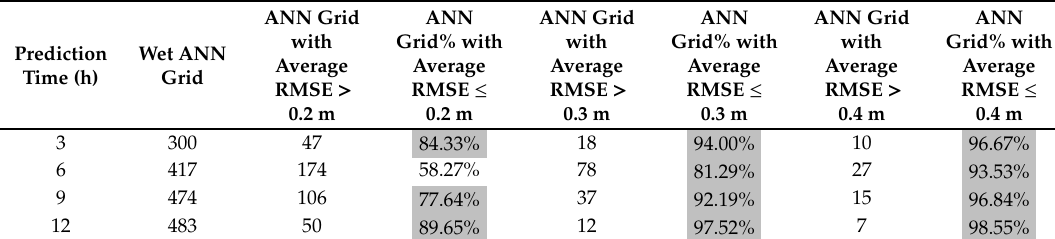
Table 1. Number of wet grids and grid percentages of di ff erent large error thresholds for testing synthetic flood events (60 events,